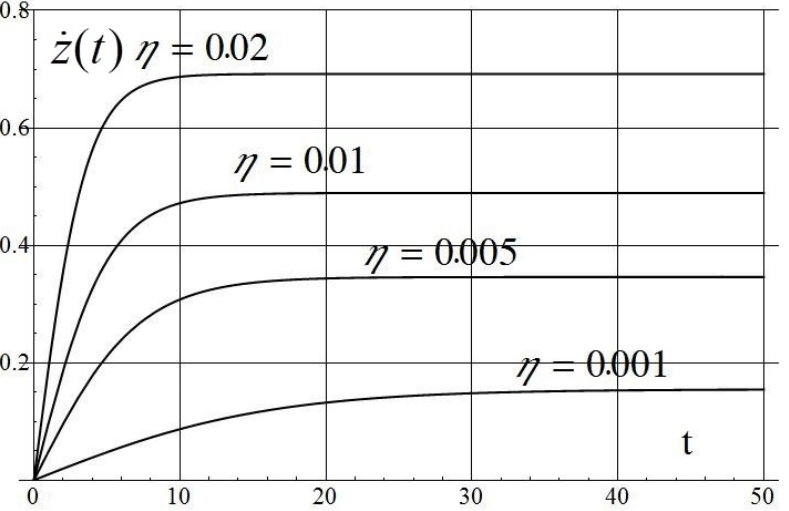
Figure 4. Speed of submersion of a sphere versus time in accelerated motion for an instantaneous change in buoyancy ( t 0 = 0 ) for various η , ds = 0.25